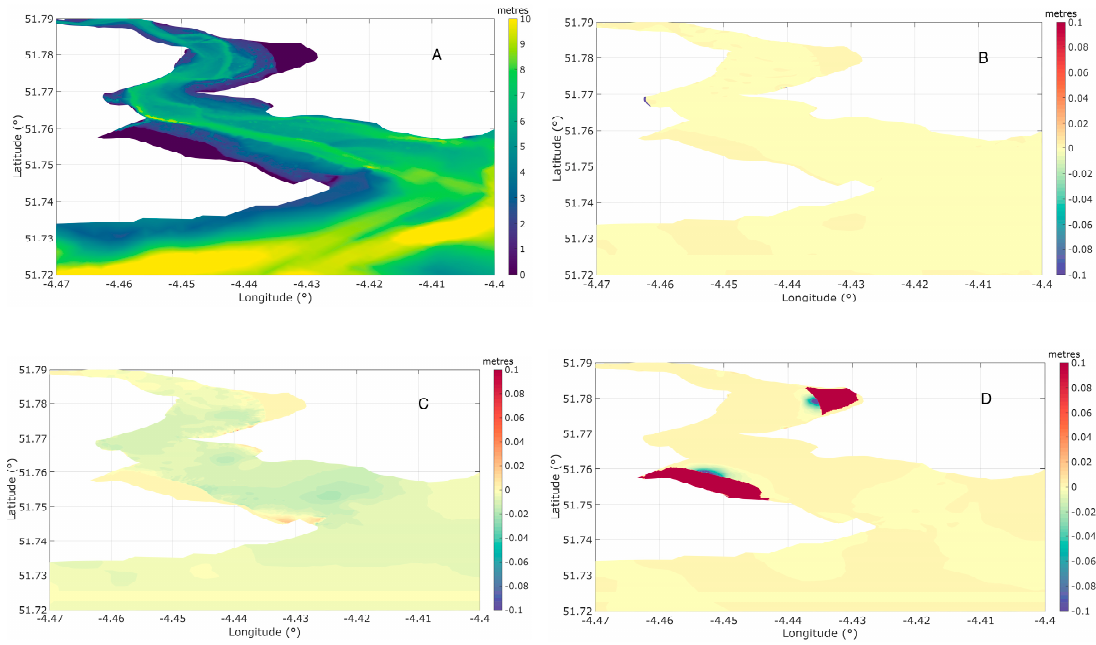
Figure 9. Comparison of peak storm water depths at the Taf Estuary under the selected intervention scenarios during the 1:50 year south ‐ westerly storm. ( a ) Current condition, ( b ) difference between defended and current condition, ( c ) difference between grazed and current condition, and ( d ) difference between managed realignment and current condition.